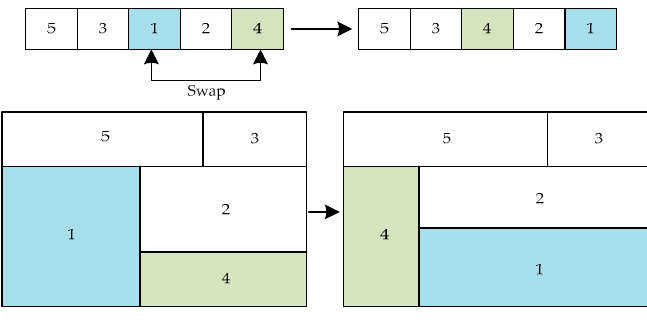
Figure 7. Swapping process.